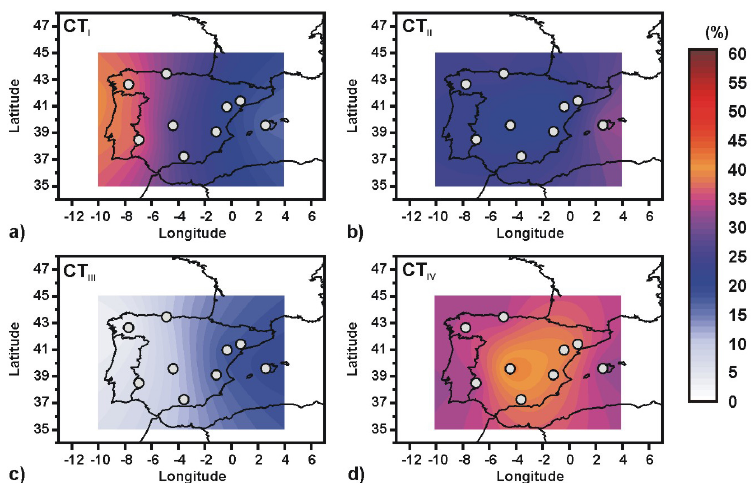
Figure 14. Interpolation maps of the impact index (%) estimated at the regional background stations, during circulation types leading to ADO over the western Mediterranean Basin in the period